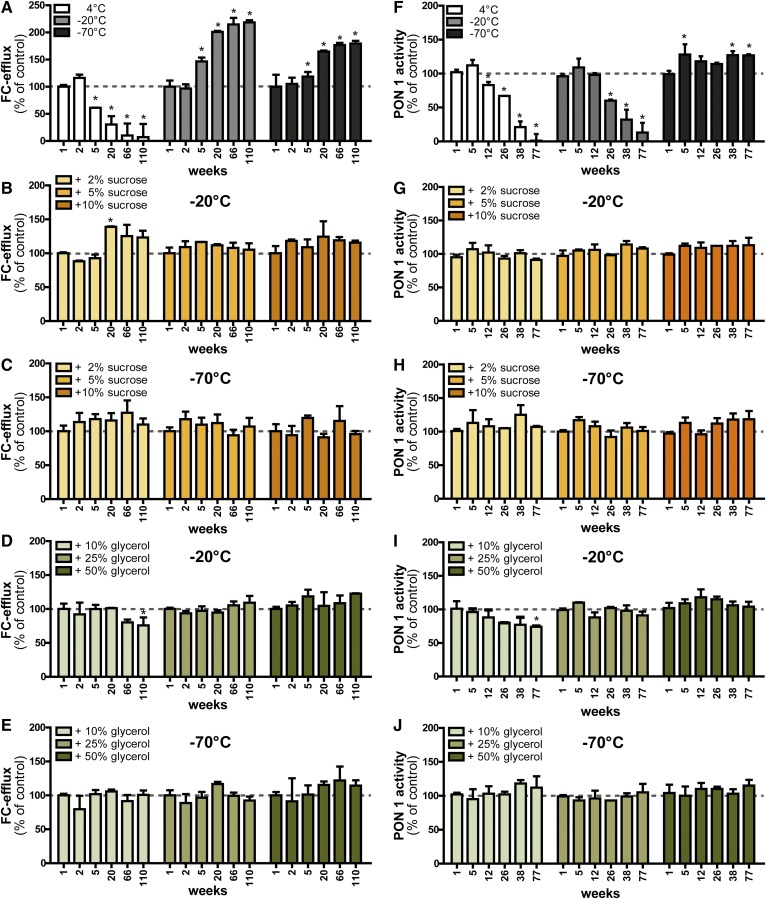
Functional analysis of cryopreserved HDL. HDL isolated by density gradient ultracentrifugation was stored at −20°C or −70°C in the presence or absence of the cryoprotectants, sucrose (2–10%) or glycerol (10–50%), for up to 110 weeks. Samples from four healthy donors were pooled and aliquots were analyzed for their ability to promote cholesterol efflux (A–E) and for their HDL-associated paraoxonase 1 activity (F–J) at indicated time points. The dashed lines indicate the control value measured right after the isolation of HDL and were used for normalization to 100%. Results represent the combined analysis of two independent experiments performed in triplicate. *P < 0.05 versus control.